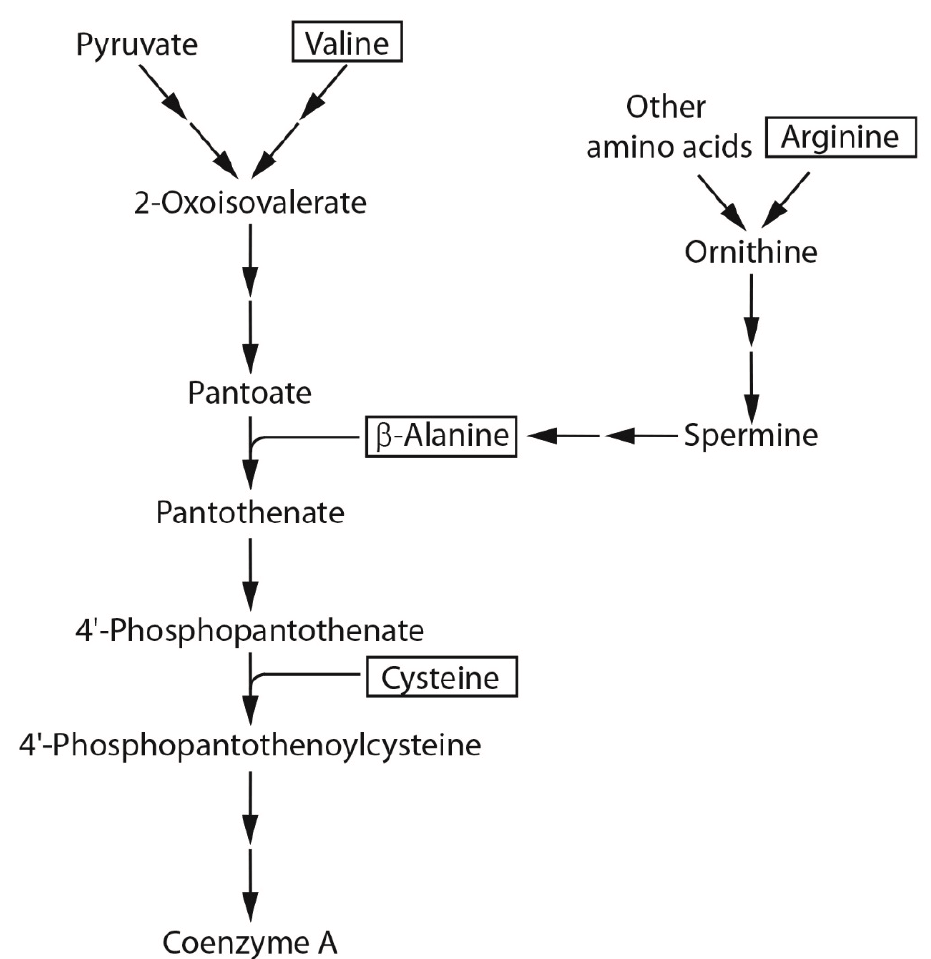
Figure 3. Simplified pathway of CoA biosynthesis in the yeast S . cerevisiae to emphasise the potential role of the four amino acids (boxed) used in this